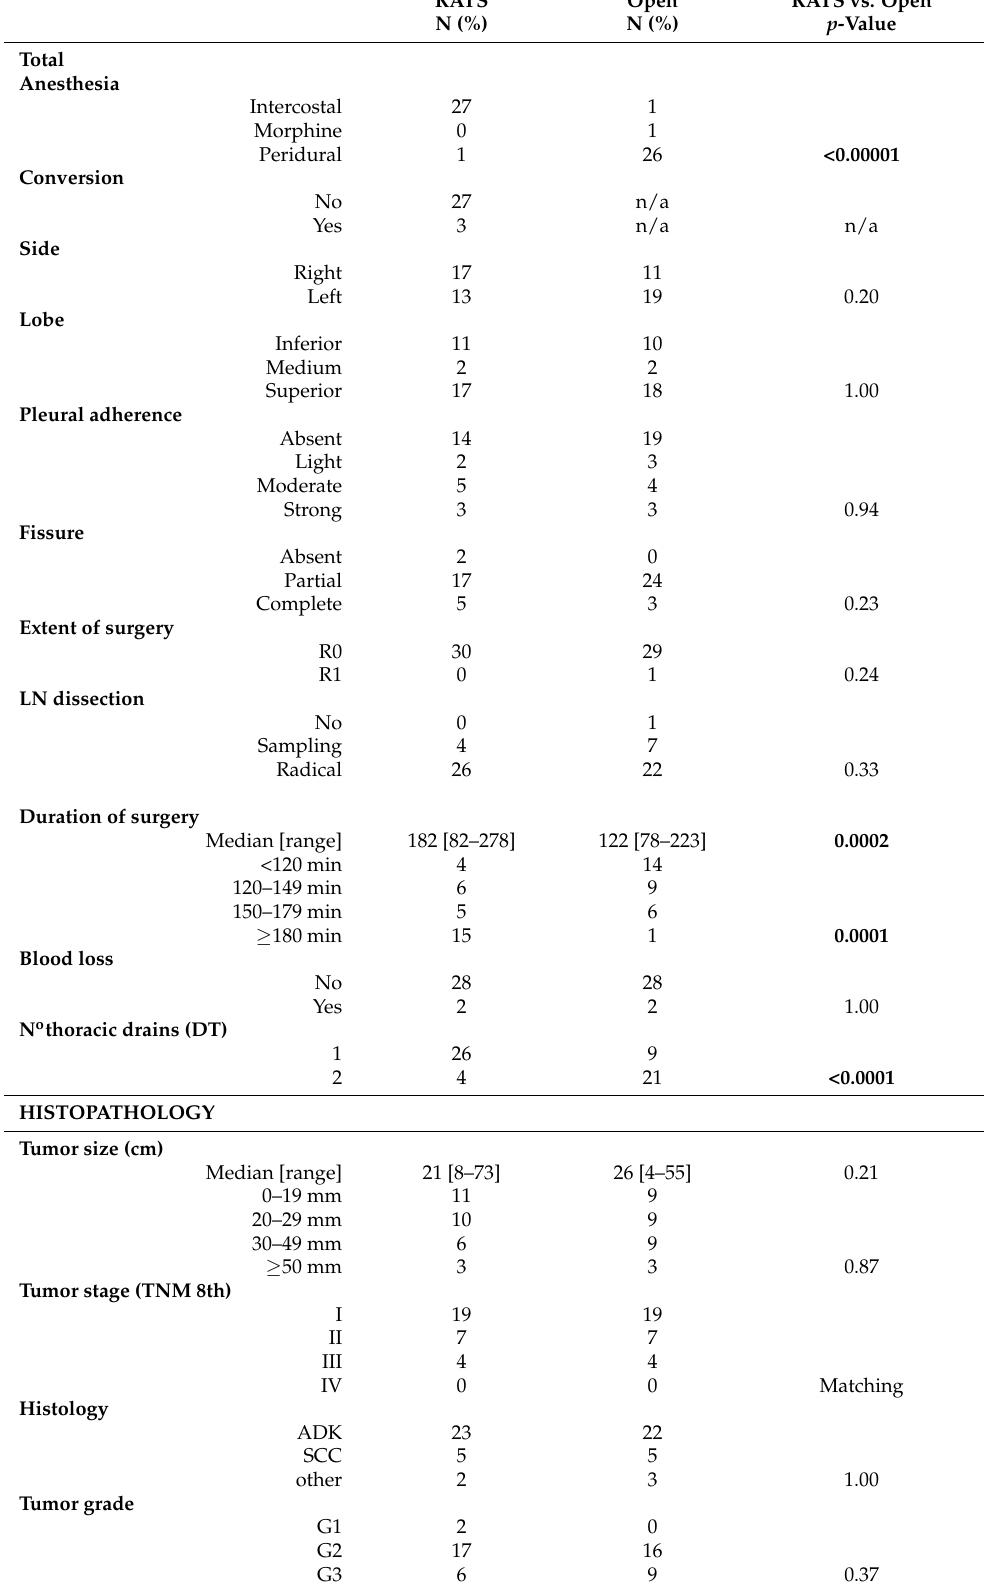
Table 2. Intervention and tumor characteristics in the matched robotic surgery (RATS) and muscle- sparing thoracotomy (OPEN) intervention